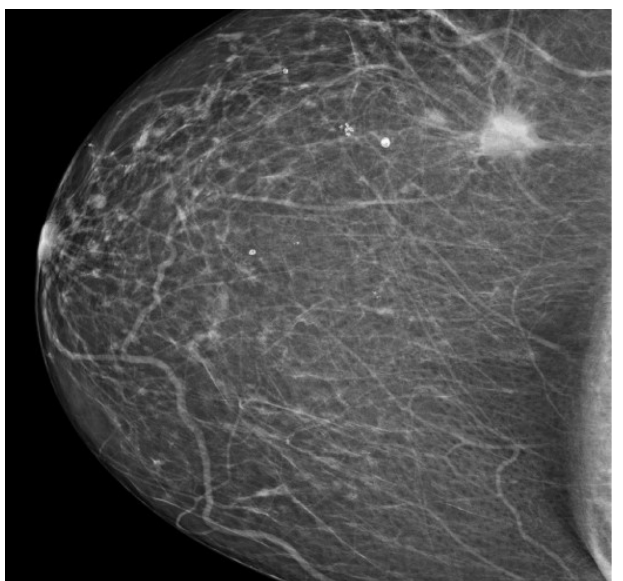
Figure 3. PET Image Showing Right Lateral Breast Mass with Fluorodeoxyglucose Uptake.